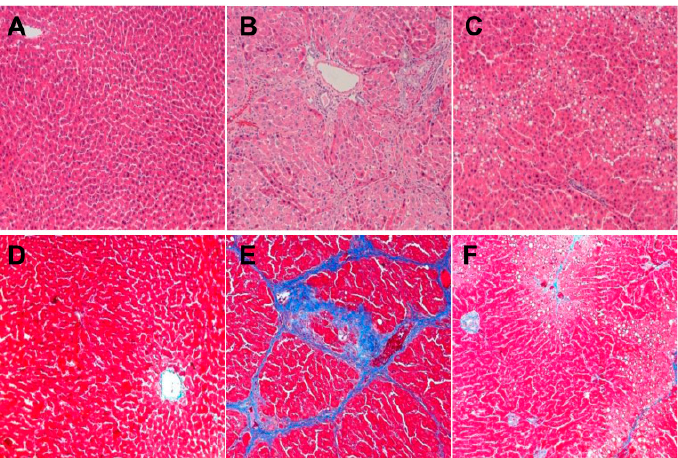
Figure 2. Liver histological changes induced by CCl 4 overload and the effects of JGG treatment in rats. Representative microscopic photographs (original magnification: ˆ 100) were obtained from: ( A ) HE staining of the control group; ( B ) HE staining of the CCl 4 model group; ( C ) HE staining of the